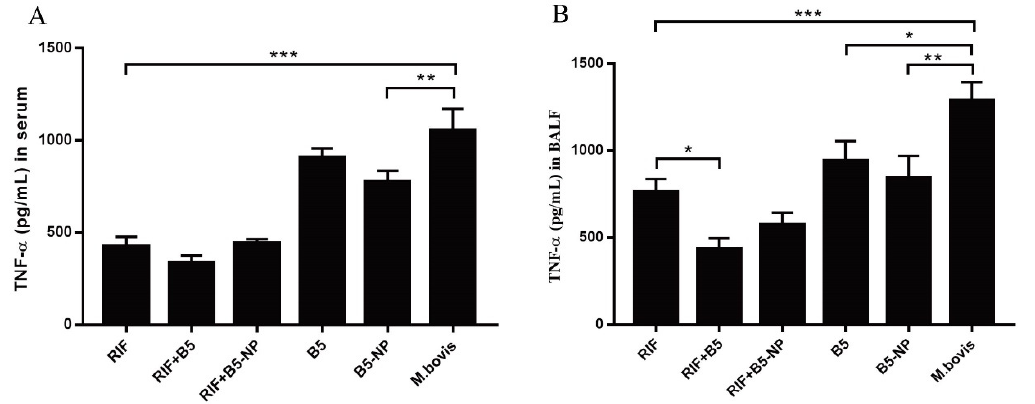
Figure 8. Effects of B5 combined with RIF on TNF ‐α secretion in serum and BALF. ( A , B ) Concentrations of TNF ‐α in serum ( A ) and BALF ( B ) were examined by ELISA. Serum and BALF were collected two weeks after the last treatment. All data showing represent the mean ± SD of three independent experiments (* p < 0.05; ** p < 0.01; *** p < 0.001).